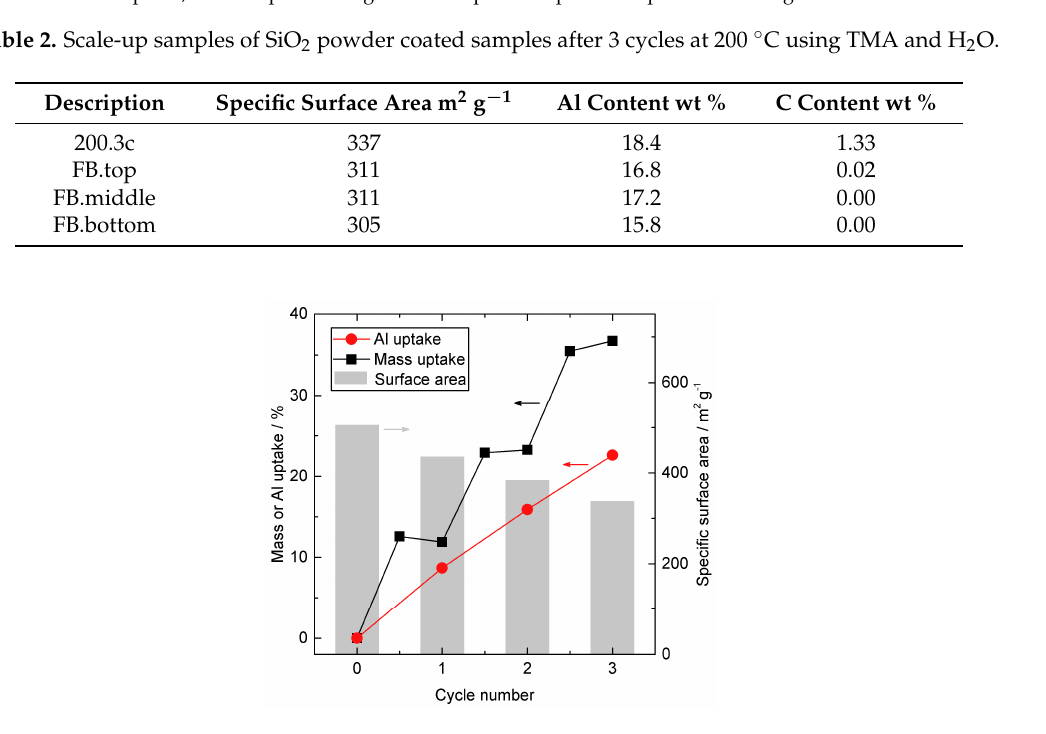
Figure 1. Specific surface area (grey, background, right axis), mass uptake in wt % (black, left axis) and uptake Al wt % (red, left axis) for the SiO 2 reference and after 1–3 ALD AlO x cycles at 200 °C. Beside the saturation curves (for details see supplemental material), the in situ gravimetry gives